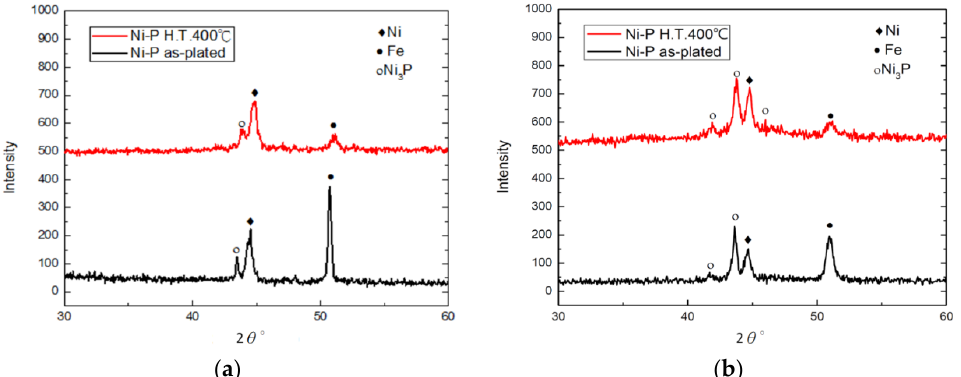
Figure 9. X-ray diffraction (XRD) patterns of worn surfaces on Ni–P and annealed Ni–P coatings: ( a ) Ni–P wear region; ( b ) annealed Ni–P wear region. ( a ) Ni–P wear region; ( b ) annealed Ni–P wear